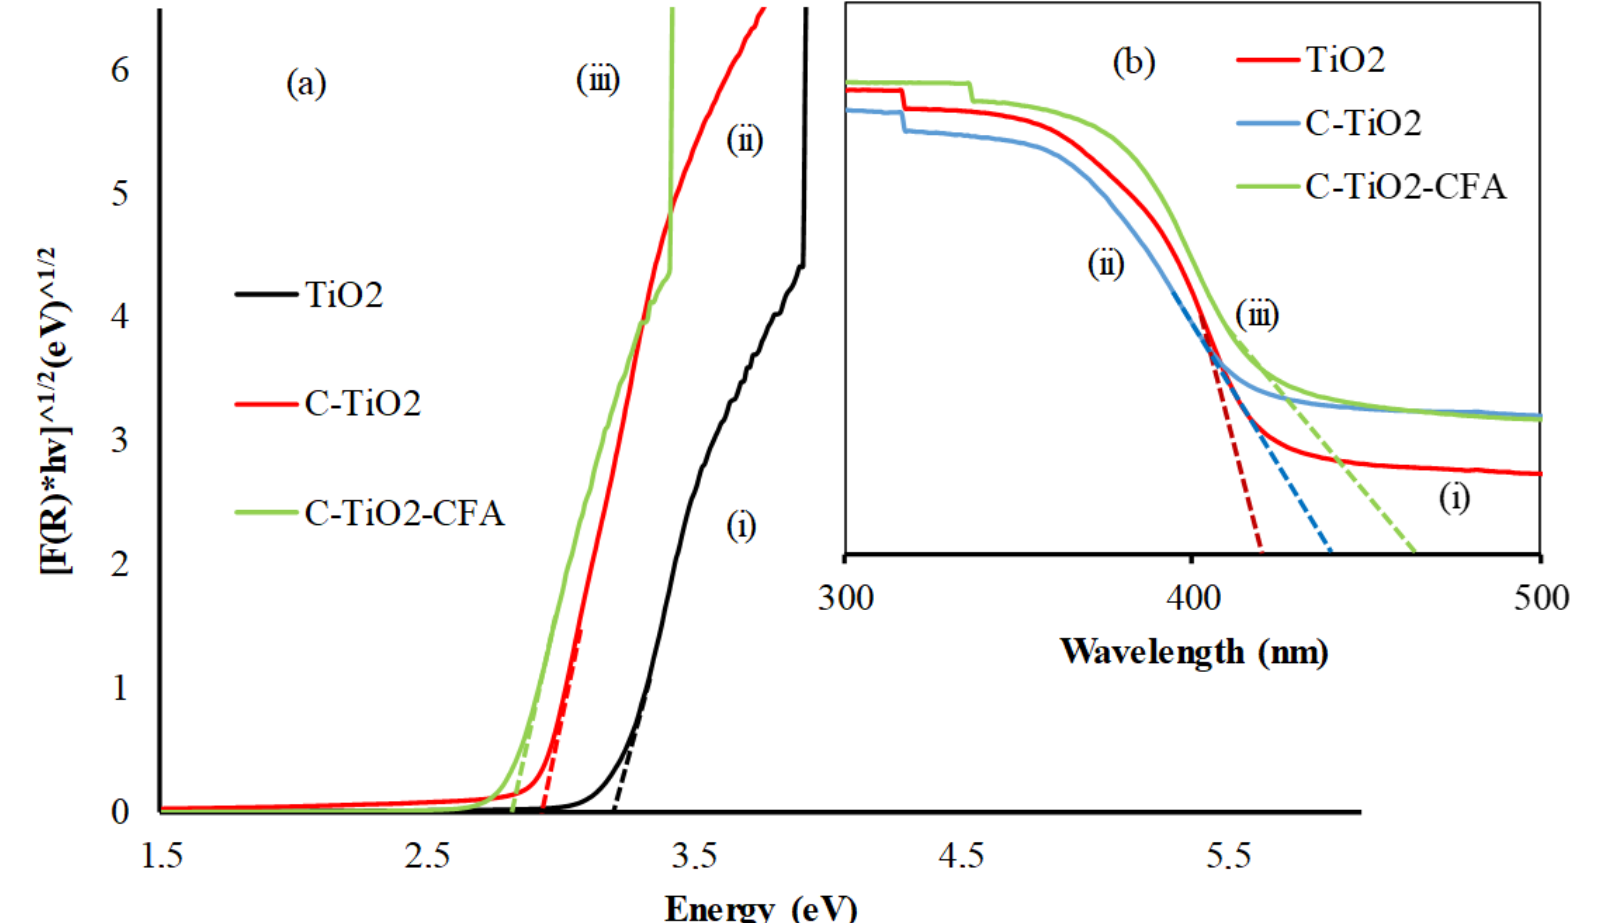
Figure 5. ( a ) Tauc plots for ( i ) TiO 2 , ( ii ) C-TiO 2 , and ( iii ) C-TiO 2 -CFA; and ( b ) DRS for ( i ) TiO 2 , ( ii ) C-TiO 2 , and ( iii ) C-TiO 2